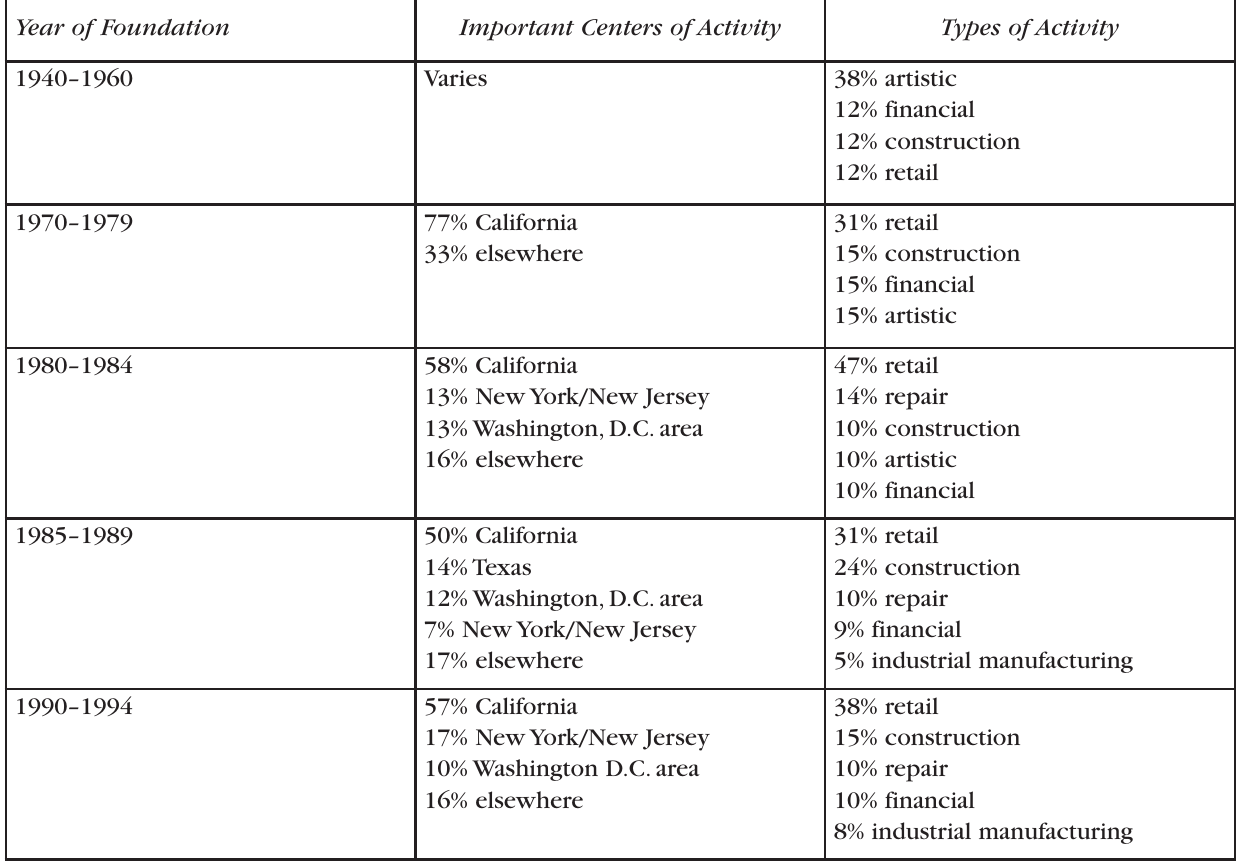
Table 5. Important Centers of Business Activities for Iranian Entrepreneurs Year of